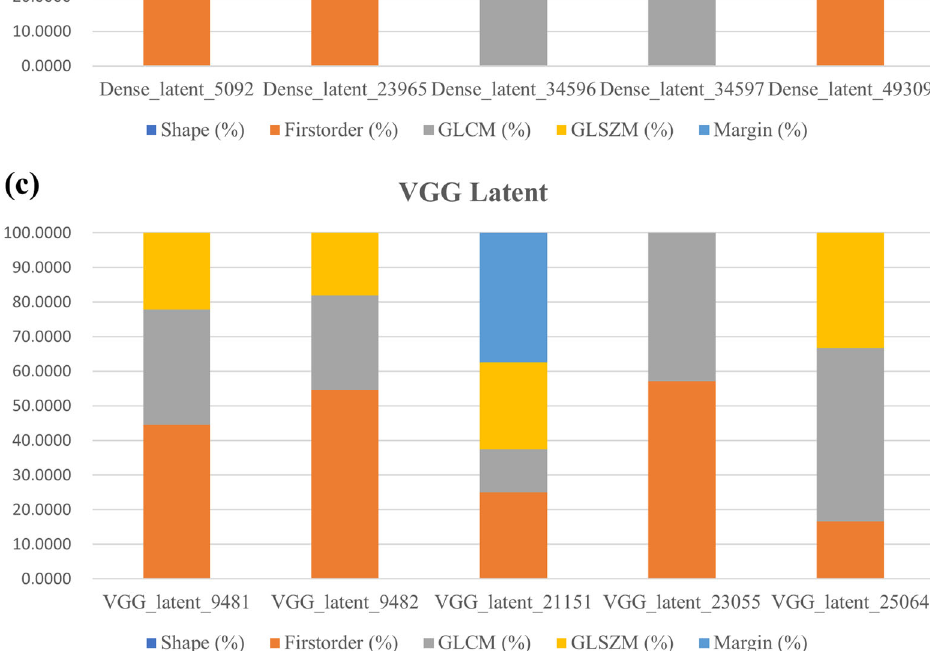
Fig. 4 Comparison of different proportions of radiomics features in fi ve categories associated with the prognostic DL features for the three networks. The fi ve categories are shape (in blue), fi rst-order (in orange), GLCM (in gray), GLSZM (in yellow), and margin (in light blue) categories. a Yolo network. b DenseNet. c